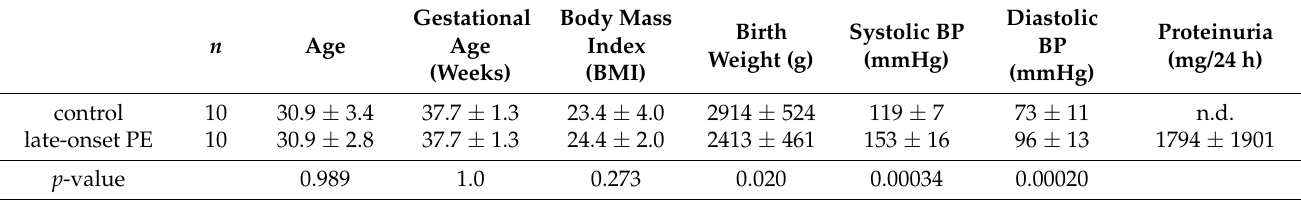
Table 3. Clinical information of patients with late-onset preeclampsia (PE) and matched controls. Mean value ± standard deviation is shown. BP, blood pressure; n.d., not determined.